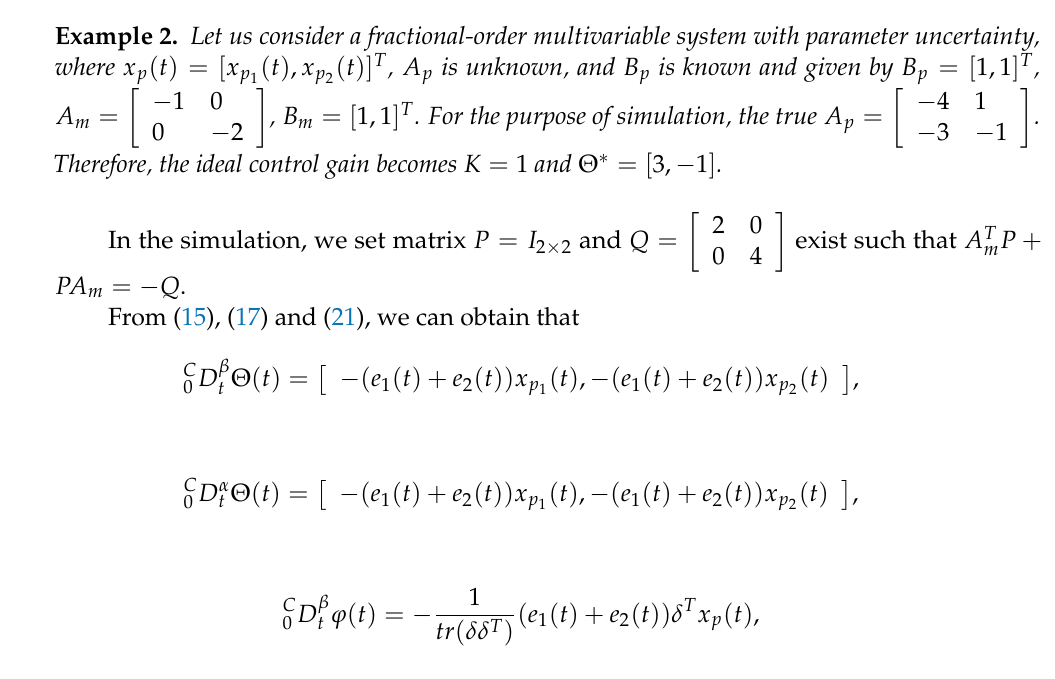
Figure 8. System response of e 2 under the external